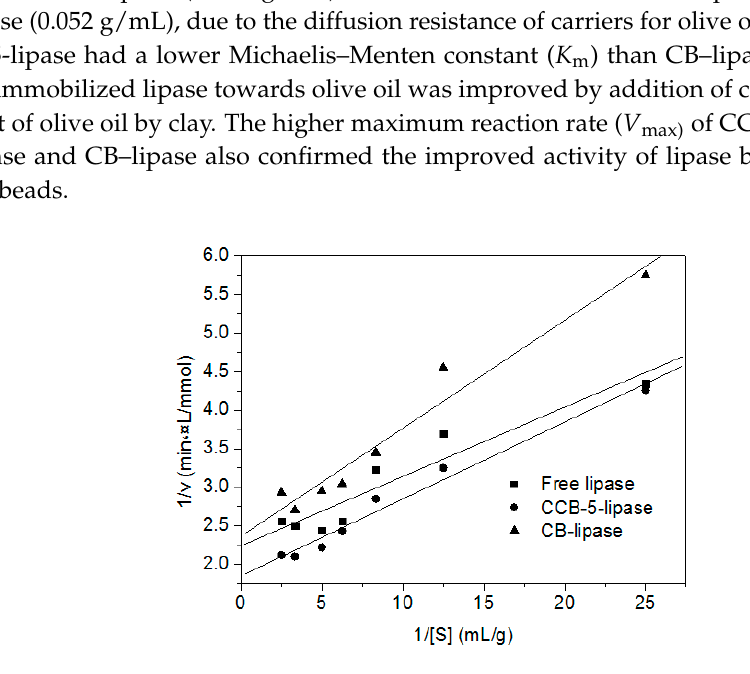
Figure 5. Lineweaver–Burk plots for free and immobilized lipases. Table 2. Kinetic parameters of free and immobilized lipases.